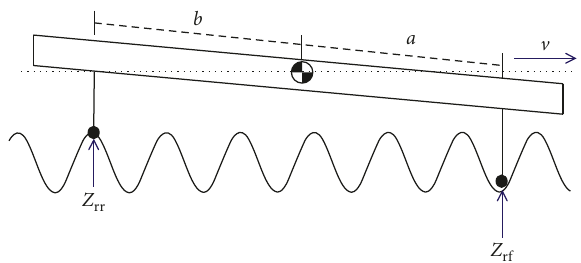
Figure 3: Disturbance inputs Z happen.